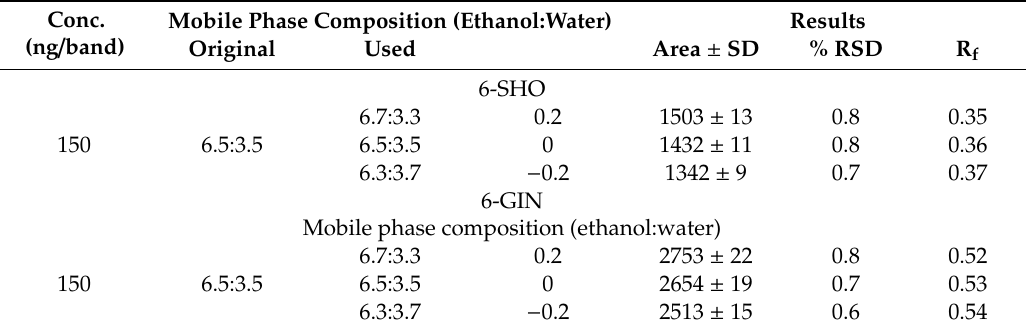
Table 4. Robustness data of 6-SHO and 6-GIN for the green RP-HPTLC method (mean ± SD; n = 6).